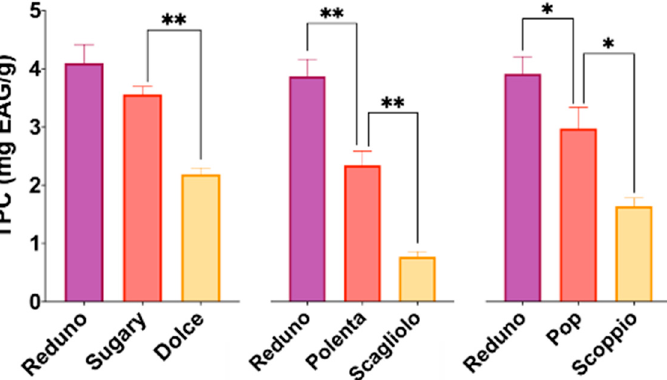
Figure 2. Soluble phenolic content (SPC) expressed as mg GAE/g (* p < 0.05, ** p < 0.01). The soluble phenolic contents of pigmented varieties (Reduno, Sugary, Polenta, and Pop) were higher than those measured in yellow ones, probably due to the contribution of anthocyanins. These values are in agreement with data by Lopez-Martinez and co-workers [24], where the soluble polyphenol content in corn samples (with different pigmented phenotypes) ranged between 0.33 and 6.80 mg GAE/g and those by Suriano and co-workers (2021), where the soluble polyphenol content in one yellow and three pigmented corn varieties ranged between 1.36 and 4.05 mg catechin equivalents/g [46]. Lower values were found by Rodríguez-Salinas and co-workers (2019), who reported a soluble polyphenol content in corn samples (15 samples from white to purple varieties) between 1.05 and 1.39 mg GAE/g [47].